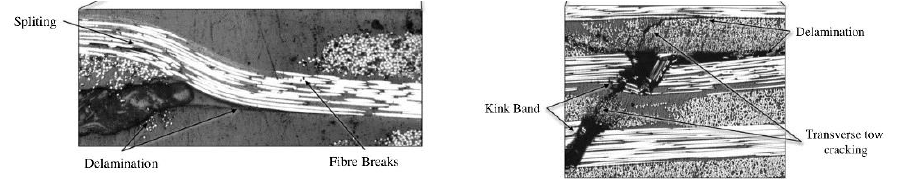
Figure 2 : Damage sources in 2D woven composite [13].